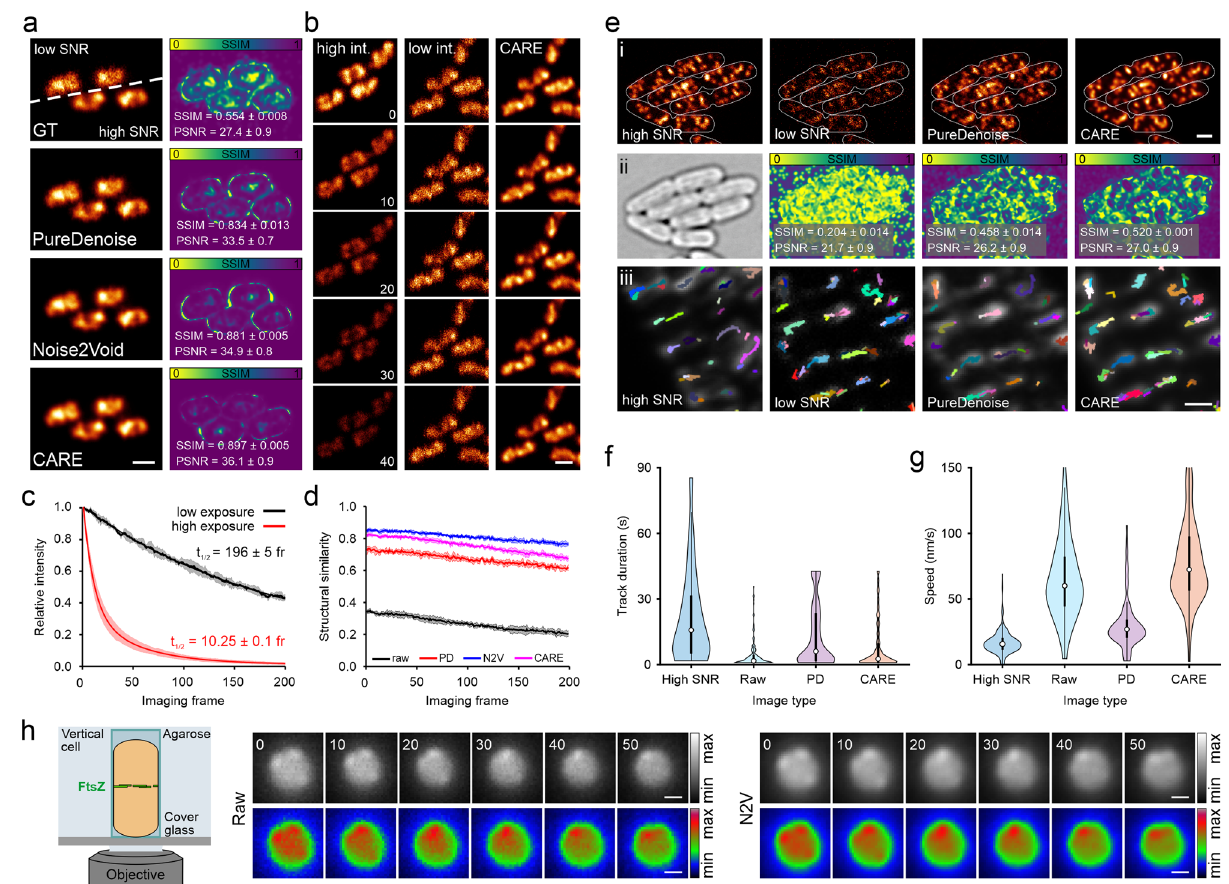
Fig. 4 Image denoising for improved live-cell imaging in bacteriology. a Low and high signal-to-noise ratio (SNR) image pairs (ground truth, GT) of fi xed E. coli cells, labelled for H-NS-mScarlet-I. Denoising was performed with PureDenoise (parametric approach), Noise2Void (self-supervised DL) and CARE (supervised DL). Structural similarity (SSIM) maps compare low-SNR or predictions to ground truth (GT) high-SNR data. b 10 s interval representative time points of a live-cell measurement recorded at 1 Hz frame rate, demonstrating CARE can provide prolonged imaging at high SNR using low-intensity images as input. t 1/2 represents the decay half time. c Intensity over time for different imaging conditions providing low/high SNR images shown in a / b . d Structural similarity between subsequent imaging frames was calculated for raw and restored time-lapse measurements (Methods). e Denoising of confocal images of MreB-sfGFP sw expressing E. coli cells, imaged at the bottom plane (i). Outlines show cell boundaries obtained in transmitted light images (ii). (ii) Transmitted light image and SSIM maps generated by comparison of raw or denoised data with the high SNR image. (iii) Tracks of MreB fi laments (colour-coded) and overlaid with the average image (grey) of a live-cell time series. Violin plots show the distribution of track duration ( f ) and speed ( g ) for the high SNR, low SNR (raw) and denoised image series, with mean values denoted by circles and percentiles by black boxes. Note that the distribution in g was cut at a max speed of 150 nm/s, excluding a small number of high-speed outliers but allowing for better visualisation of the main distribution. h Denoising of FtsZ-GFP dynamics in live B. subtilis . Cells were vertically trapped and imaged using the VerCINI method 47 . Details are restored by Noise2Void (N2V), rainbow colour-coded images were added for better visualisation. Values in a and e represent mean values derived from 2 (a) and 5 (e) images and the respective standard deviation. c , d Show mean values and respective standard deviations from 3 measurements. f , g Show tracking results from individual time series. Scale bars are 1 µ m ( a , b , e i) and 0.5 µ m ( e iii and h